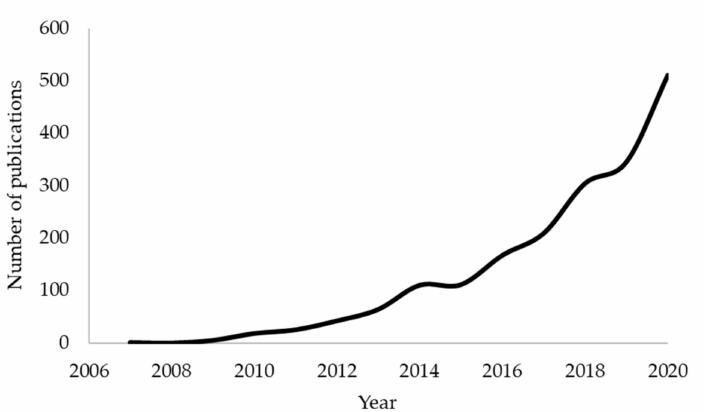
Figure 1. Yearly development and increasing interest in biochar research, based on the keywords ‘biochar’ and ‘soil